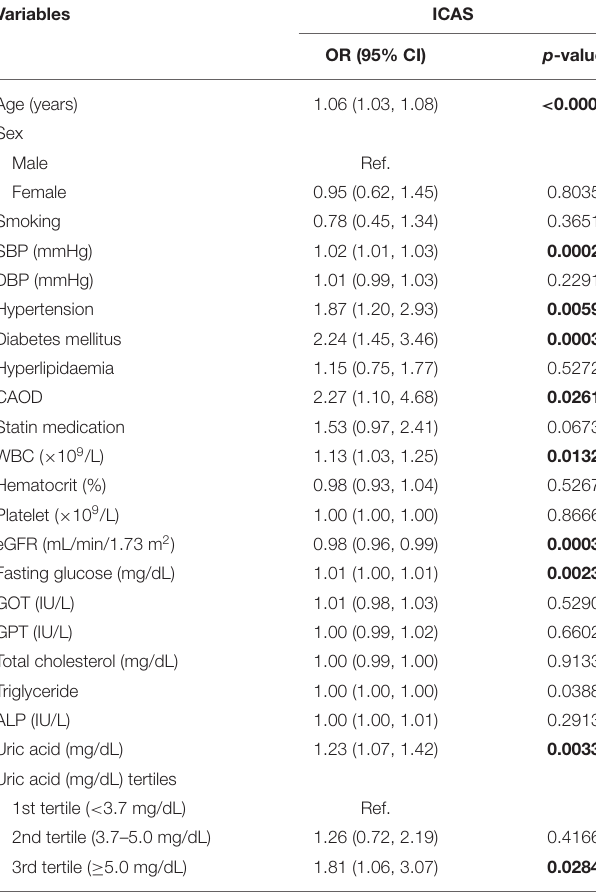
TABLE 1 | Baseline characteristics of study population by ICAS. TABLE 2 | Univariate analysis of